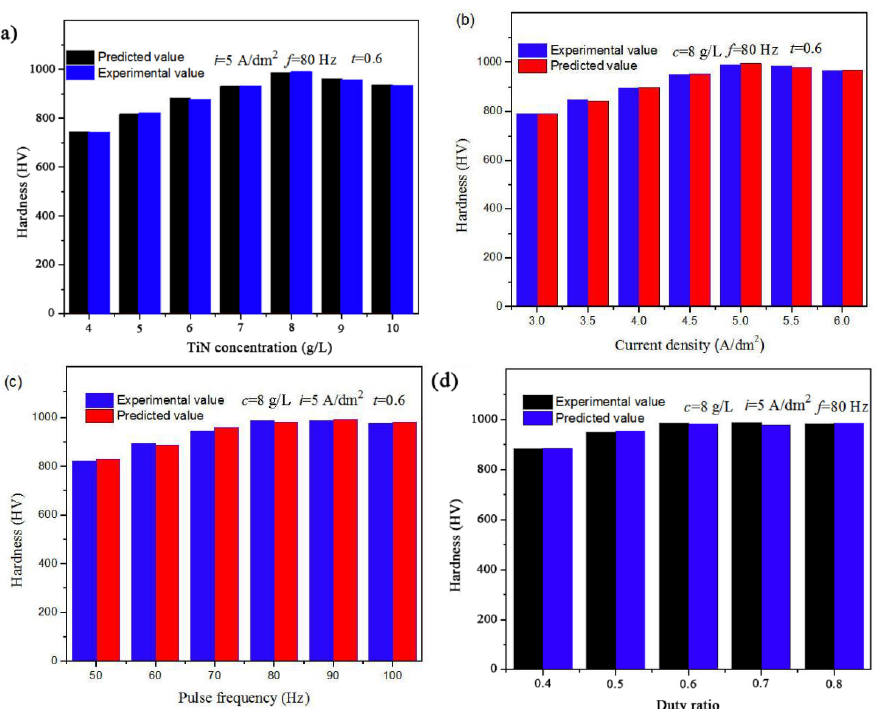
Figure 9. Effects of plating parameters on micohardnesses of Ni-TiN nanoplatings: ( a ) TiN concen- tration; ( b ) Currect density; ( c ) Pulse frequency; ( d ) Duty ratio. tion; ( b ) Currect density; ( c ) Pulse frequency; ( d ) Duty